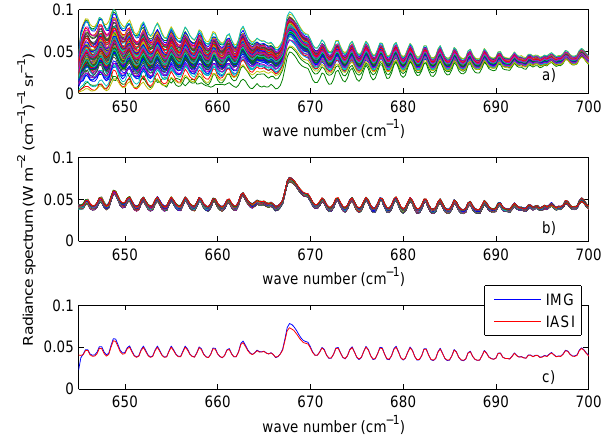
Fig. 2. This figure illustrates how much more accurate the IASI spectra in the long wave CO 2 absorption band are in comparison with those measured by an equivalent, albeit ten years older, in- strument, namely the Japanese IMG (Interferometric Monitoring of Greenhouse Gases, Kobayashi et al. (1999)). The comparison focuses on the range 645 to 700cm − 1 . Panel (a) shows a set of sea-surface IMG spectra (see Masiello et al. (2003)) recorded in the tropics; panel (b) shows an equivalent set of IASI spectra also recorded in the tropics; the panel (c) shows the averaged value of the spectra shown in panel (a) and (b) , respectively. The good agree- ment between the mean values shown in panel (c) means that the variability seen in panel (a) is just